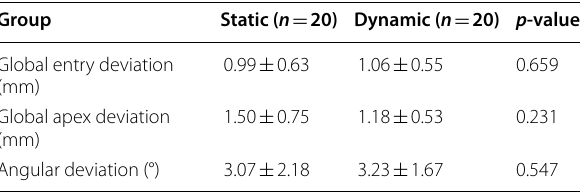
Table 2 The primary outcomes of global implant deviations at entry, apex, and angular deviation (mean